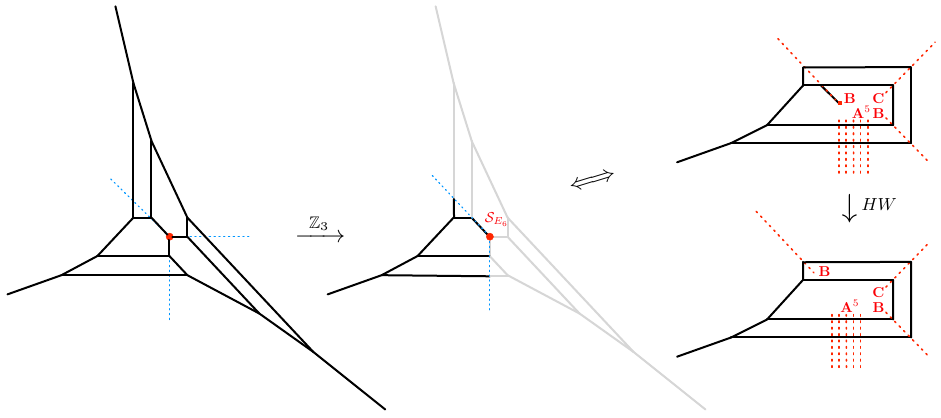
Figure 24 . The Z 3 quotient of a rank-6 non-Lagrangian theory, B 5 , leading to 5d Sp(2) + 5 F .